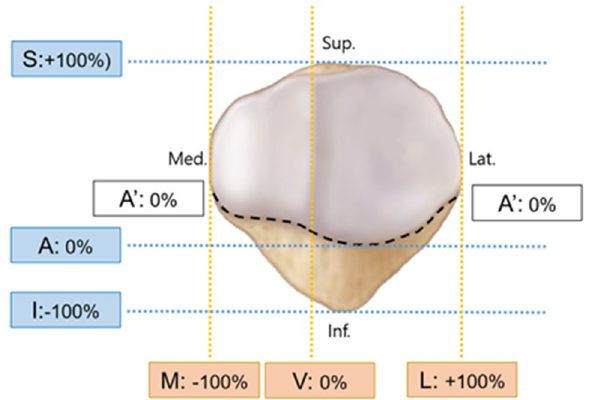
Figure 2. The reference lines for quantification of the fracture, Vertical references were S: the superior end of the patella (+ 100%), A: the lowest margin of articular facet (0%), I: inferior end of the patella (− 100%), A ′ : inferior boundary of the articular facet, Horizontal references were M: medial end of the patella (− 100%), V: vertical ridge, L: lateral end of the